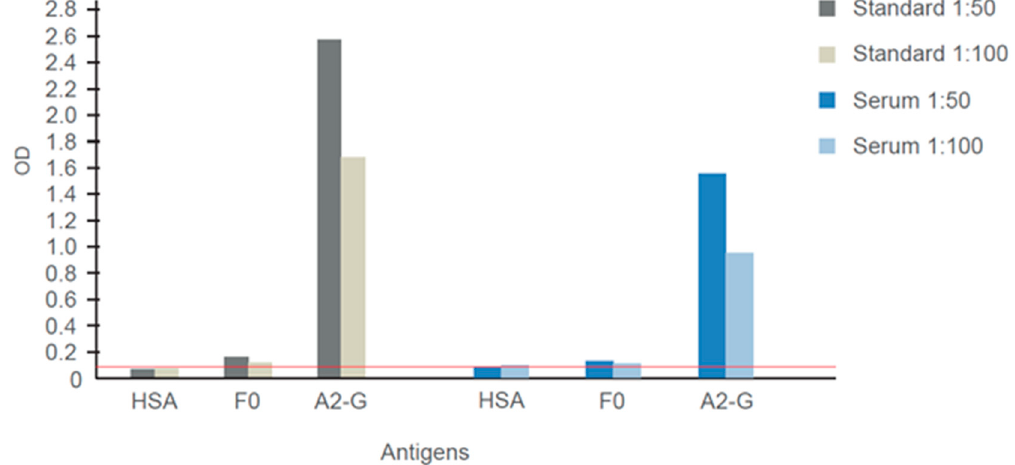
Figure 9. IgG responses specific for G and F0 determined in the WHO 1 st International Standard for Antiserum to Respiratory Syncytial Virus and another virus-neutralizing human serum. Shown are means of optical density (OD) values ( < 5% deviation) corresponding to IgG levels specific for G, F0 and human serum albumin determined for different dilutions (1:50, 1:100). The cut-off (mean of buffer control plus three times standard deviation) is indicated by a horizontal red line.